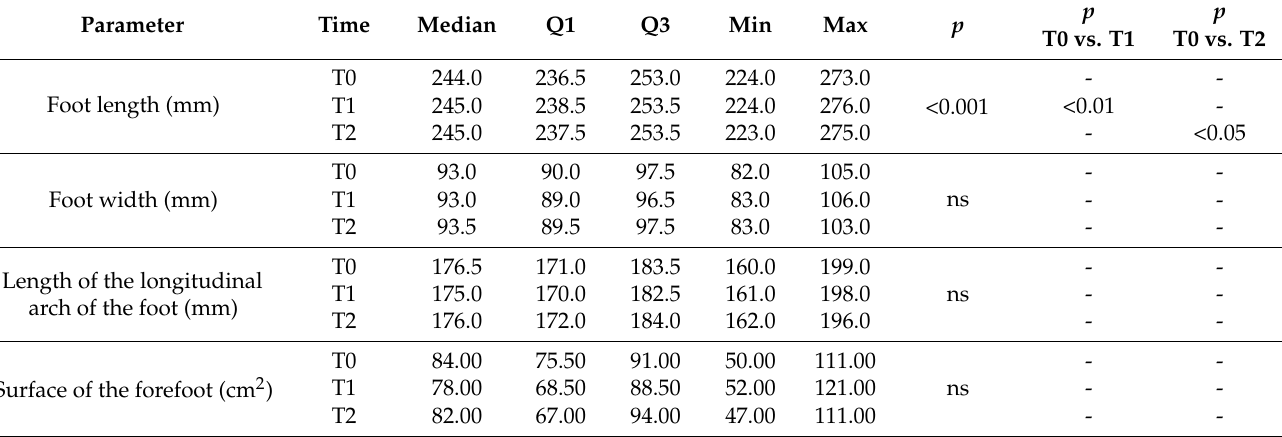
Table 1. Selected anthropometric and static foot parameters before using the kinesiology taping (T0), after the application of the taping (T1) and after its removal following a month of using the taping (T2); Q1 = first quartile, Q3 = third quartile, Min = minimum, Max = maximum, p = statistical significance, ns = no statistical significance.